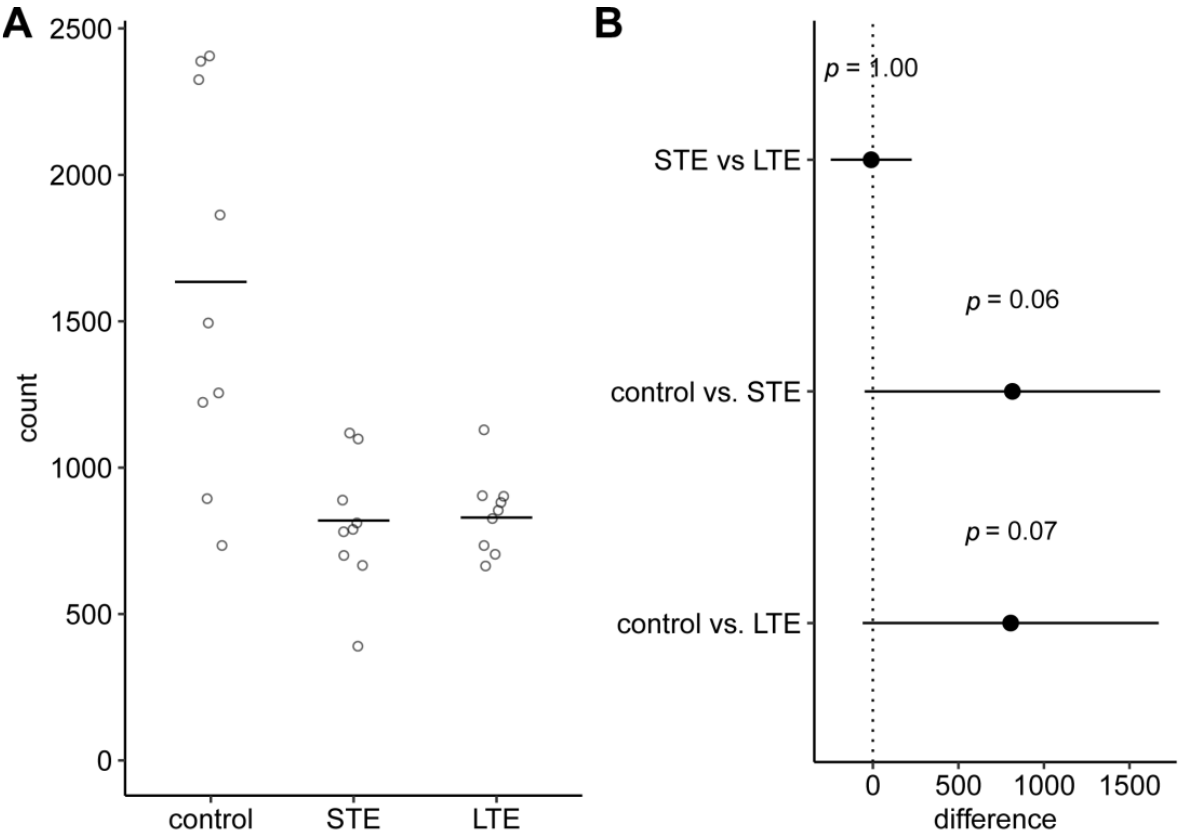
Figure 1. Effect of blue light exposure on number of melanopsin positive intrinsically photosensitive retinal ganglion cells (ipRGCs) in whole-mount retinas from Wistar rats. The rats were exposed to 12 h white light (150 lx) and 12 h darkness for 10 d (control, CTRL; 9 rats), cycles of 12 h blue light (150 lx) and 12 h darkness for 10 d (long-term exposure, LTE; 9 rats), and constant blue light (150 lx) for 2 d (short-term exposure, STE; 9 rats). ( A ) Circles show number of melanopsin positive ipRGCs in a whole-mount retina from one rat. Horizontal lines show 20%-trimmed mean. ( B ) Dot shows difference between group means. Error bar shows 95% confidence interval for the difference. p -values and confidence intervals were calculated with Wilcox’s robust technique based on trimmed means [34,35].